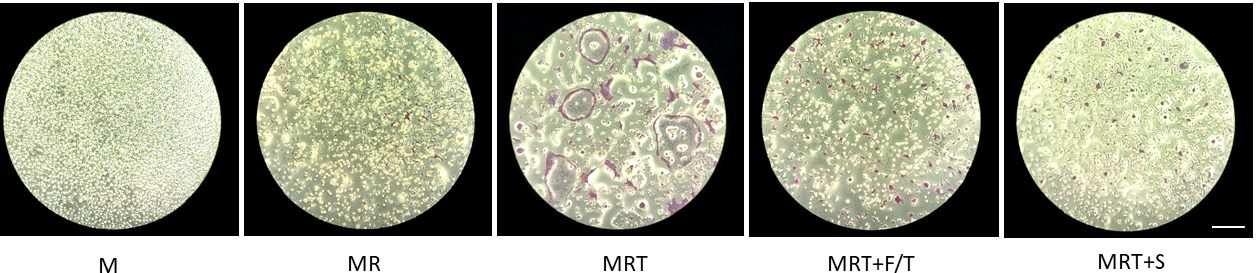
Figure 6. ST2 lysates reduce osteoclast differentiation induced by RANKL, MCSF, and TGF- β .